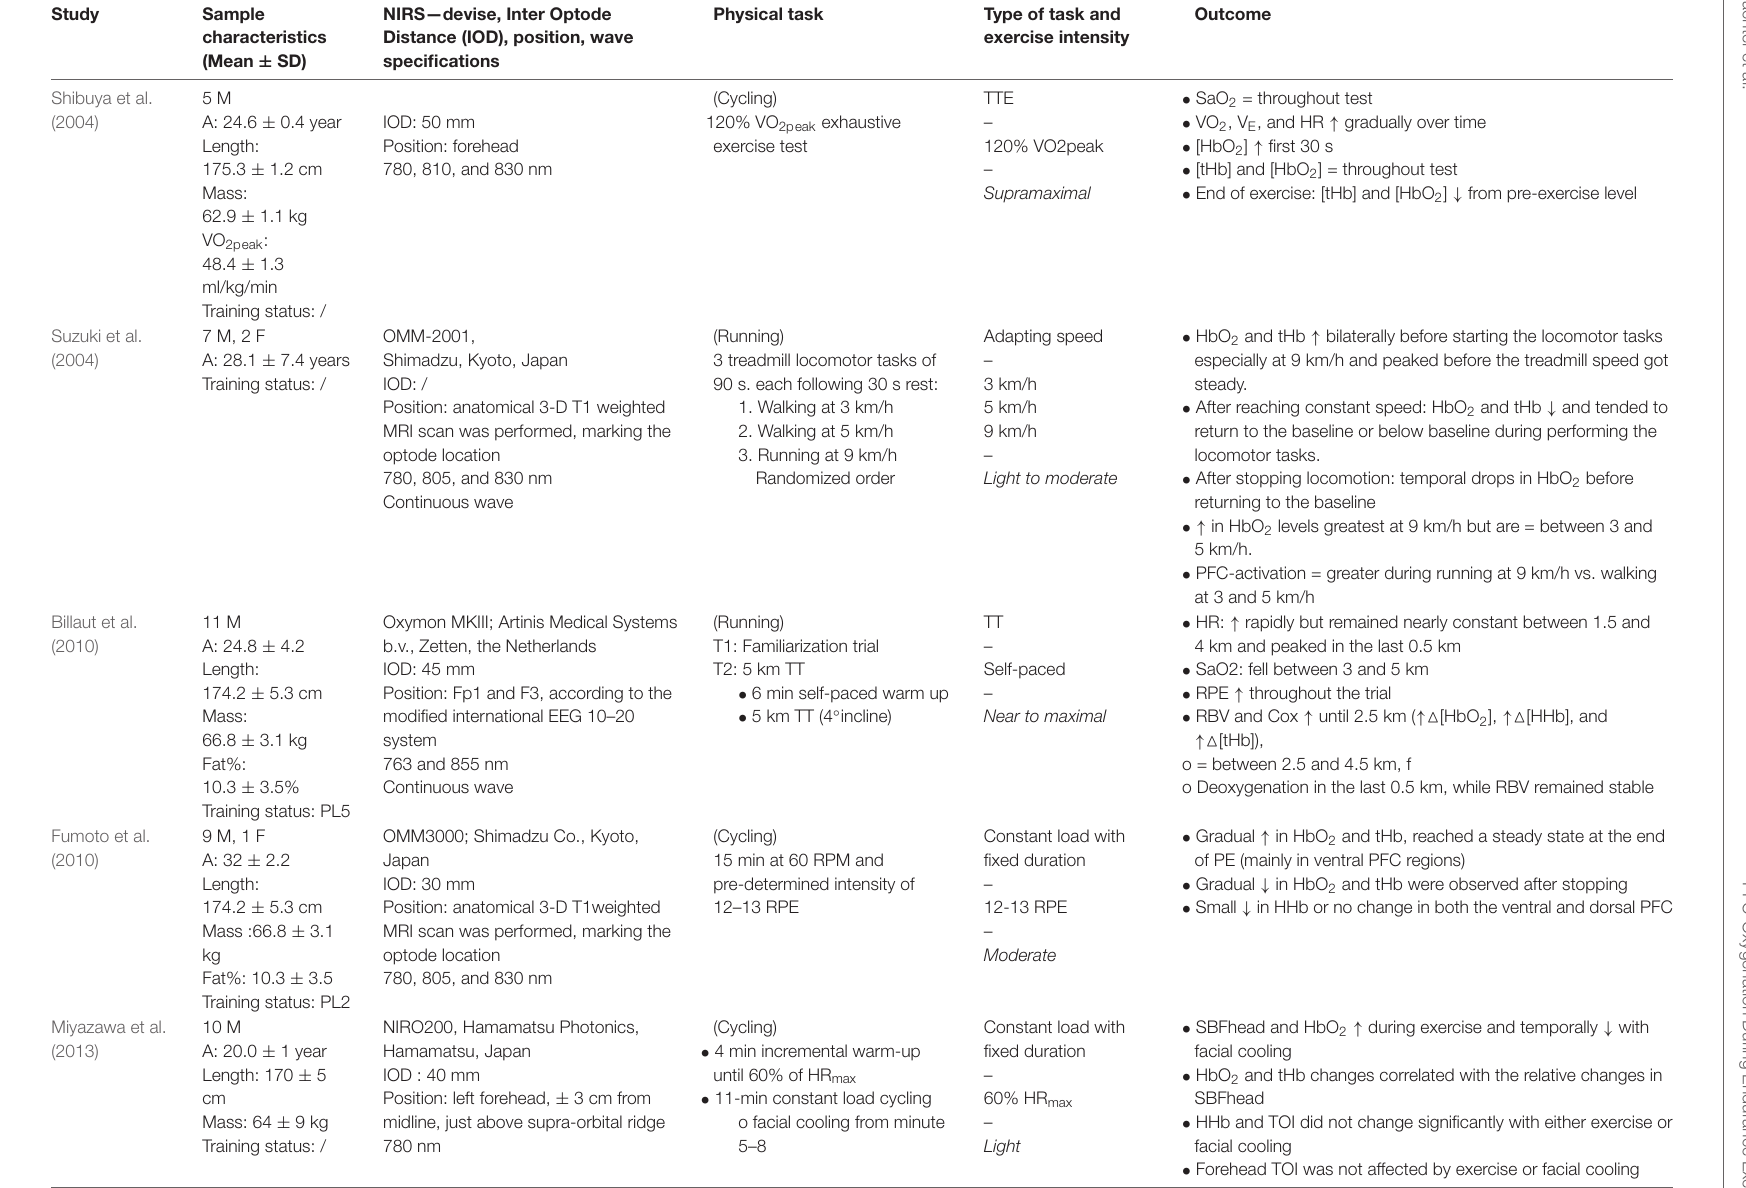
TABLE 5A | Overview of the results within “non-incremental endurance exercise”.